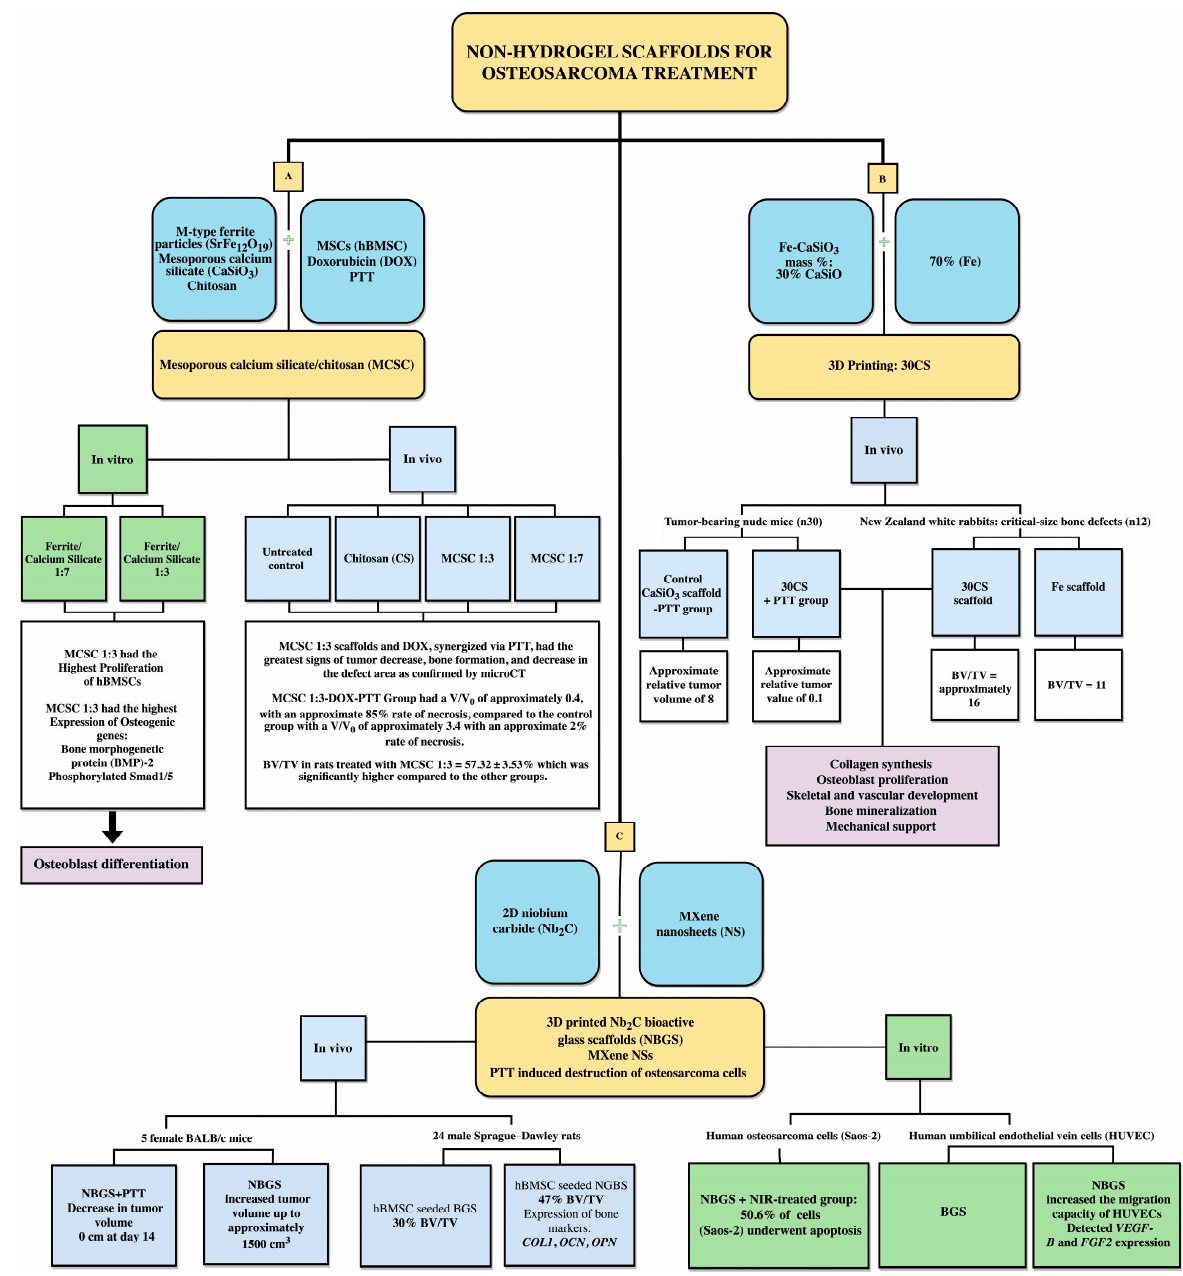
Figure 6. Schematic overview of some preclinical studies on the use of non-hydrogel scaffolds for the treatment of osteosarcoma [99,103,109].